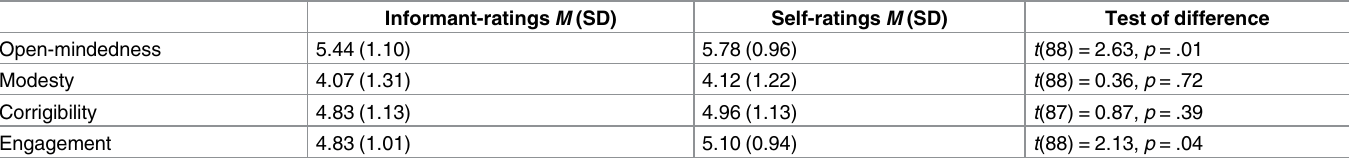
Table 8. Comparison of informant- and self-ratings of the four IH